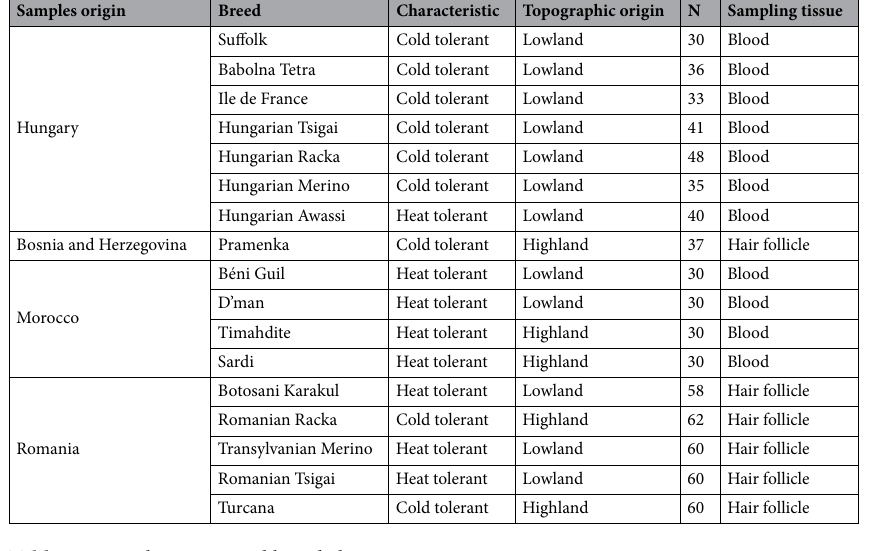
Table 1. Samples origin and breed characteristics.